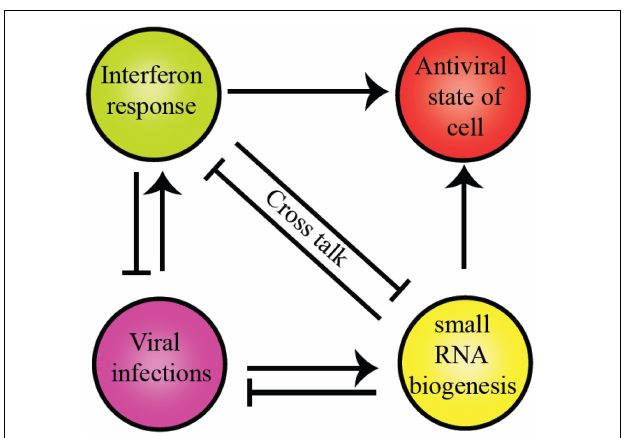
FIGURE 4 | Crosstalk between RLR family of proteins and RNAi pathway components present in humans. The commonality between the two is the evolutionarily conserved helicase domain. Both pathways establish an antiviral state within the cells to maintain cell homeostasis. However, the presence of a particular response inhibits other pathways to supersede the antiviral